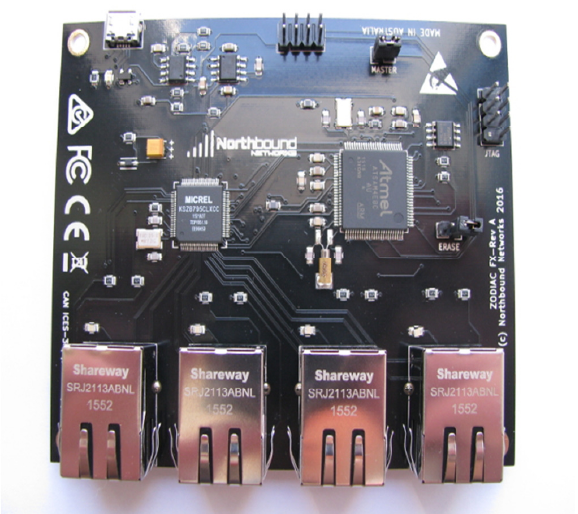
Figure 6. Zodiac FX a hardware Switch